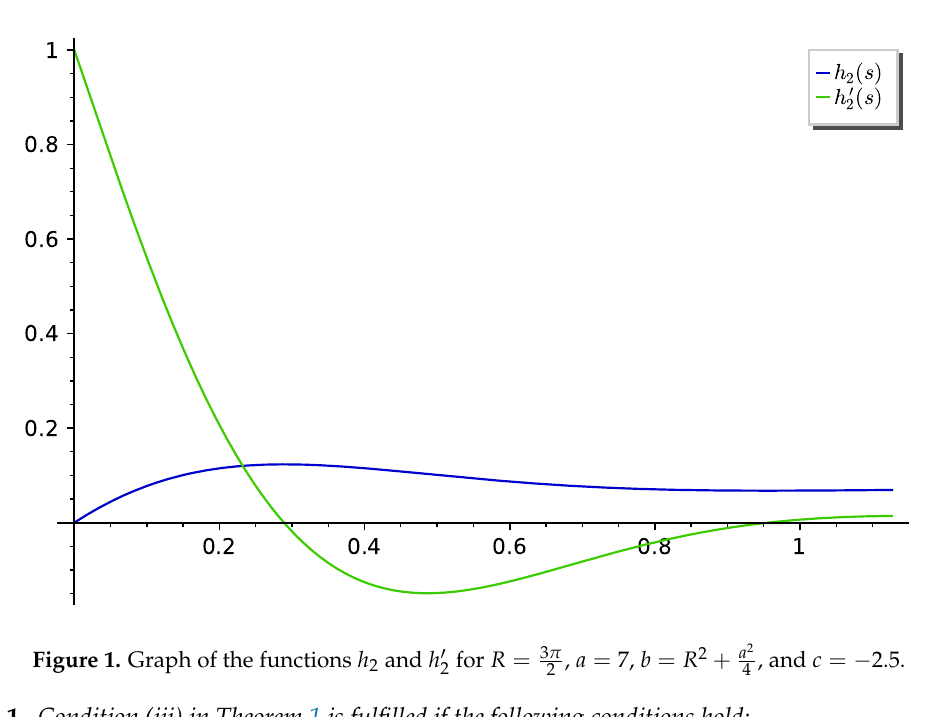
Figure 1. Graph of the functions h 2 and h (cid:48)